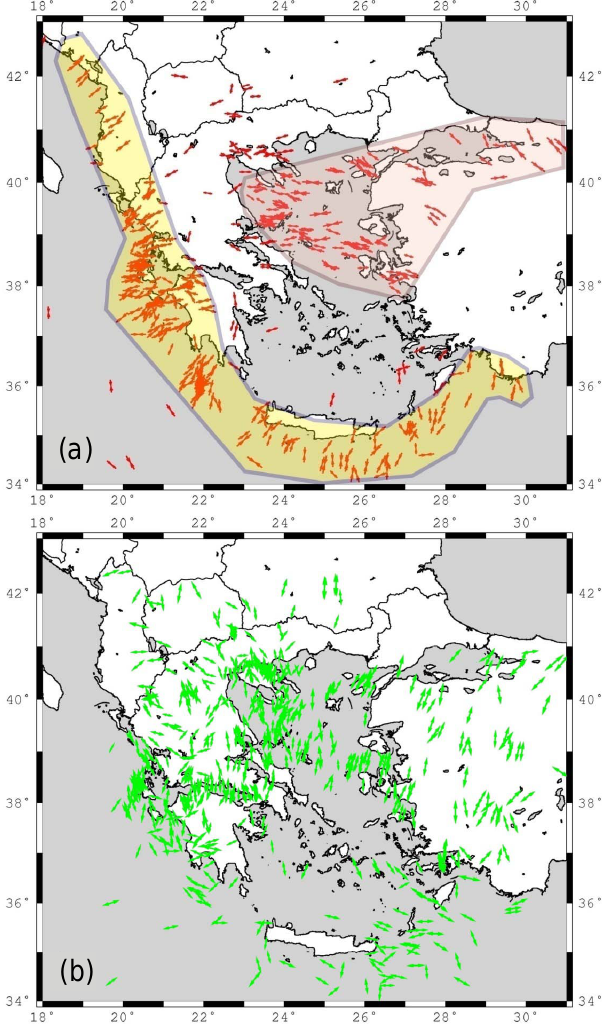
Figure 3. (a) Map of the broader Aegean area, showing the prin- cipal compression kinematic axes ( P ) derived from the fault plane solutions, collected for the determination of the new seismic zona- tion model. (b) Same as (a) for the principal extension kinematic axes ( T ).